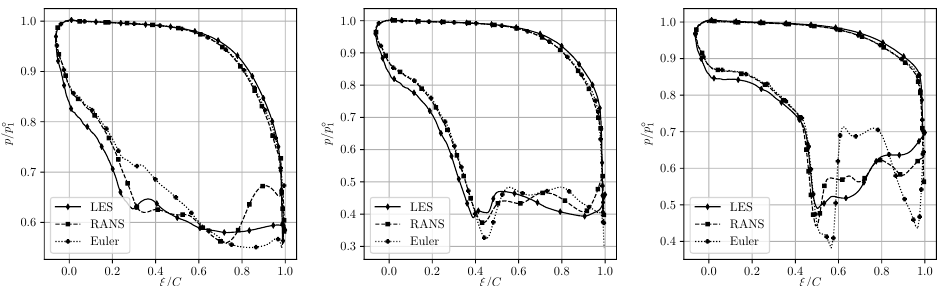
Figure 9. Normalized pressure distributions along the wall for cases IC1-LPR ( left ), IC1-HPR ( middle ), and IC2-LPR ( right ). ξ / C denotes the normalized chordwise